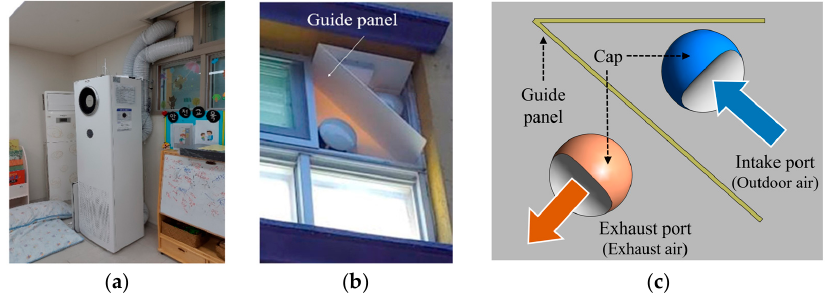
Figure 2. The interior and exterior appearance according to installation of the ventilation system: ( a ) the ventilation system installed indoor; ( b ) ventilation cap and guide panel to prevent recirculation (Outdoor); ( c ) modeling of ventilation cap and guide panel.